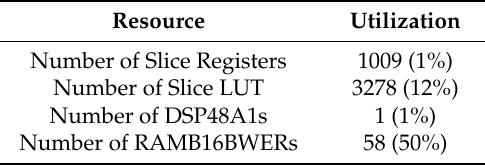
Table 1. FPGA resources utilization summary.